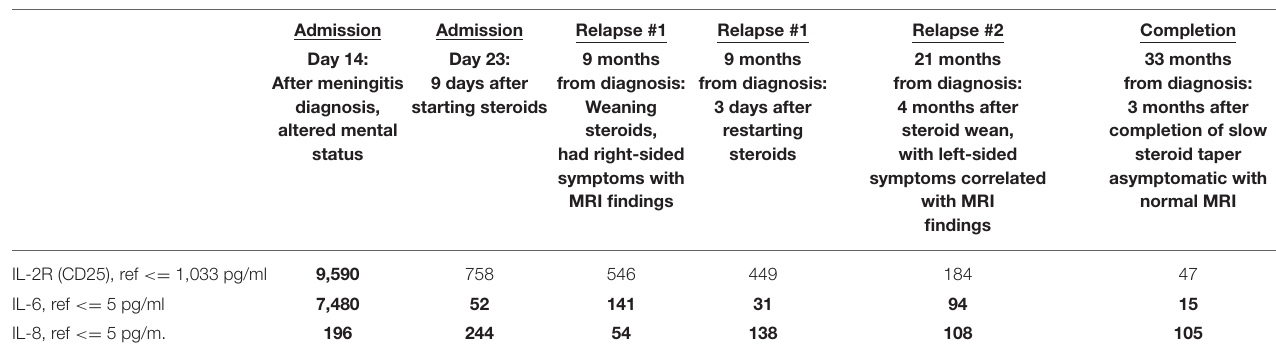
TABLE 1 | Cerebrospinal fluid (CSF) cytokine levels over time, during symptomatic periods.